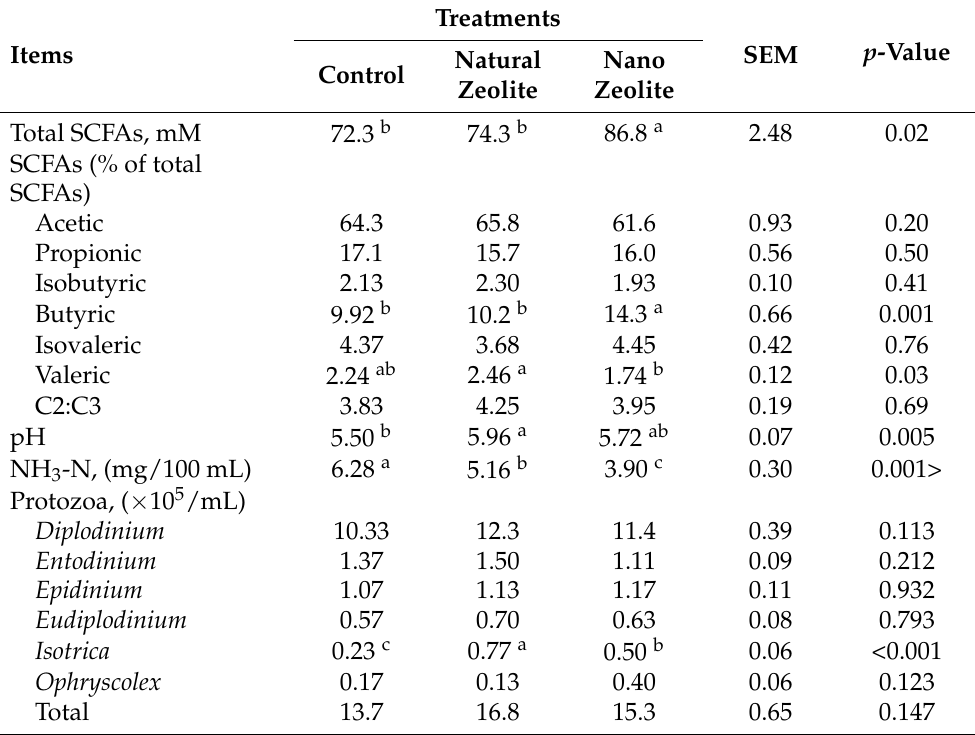
Table 6. Supplementation effects of natural or nano-zeolite on goat rumen fermentation parameters and protozoal count 3 h post-feeding ( in vivo experiment).